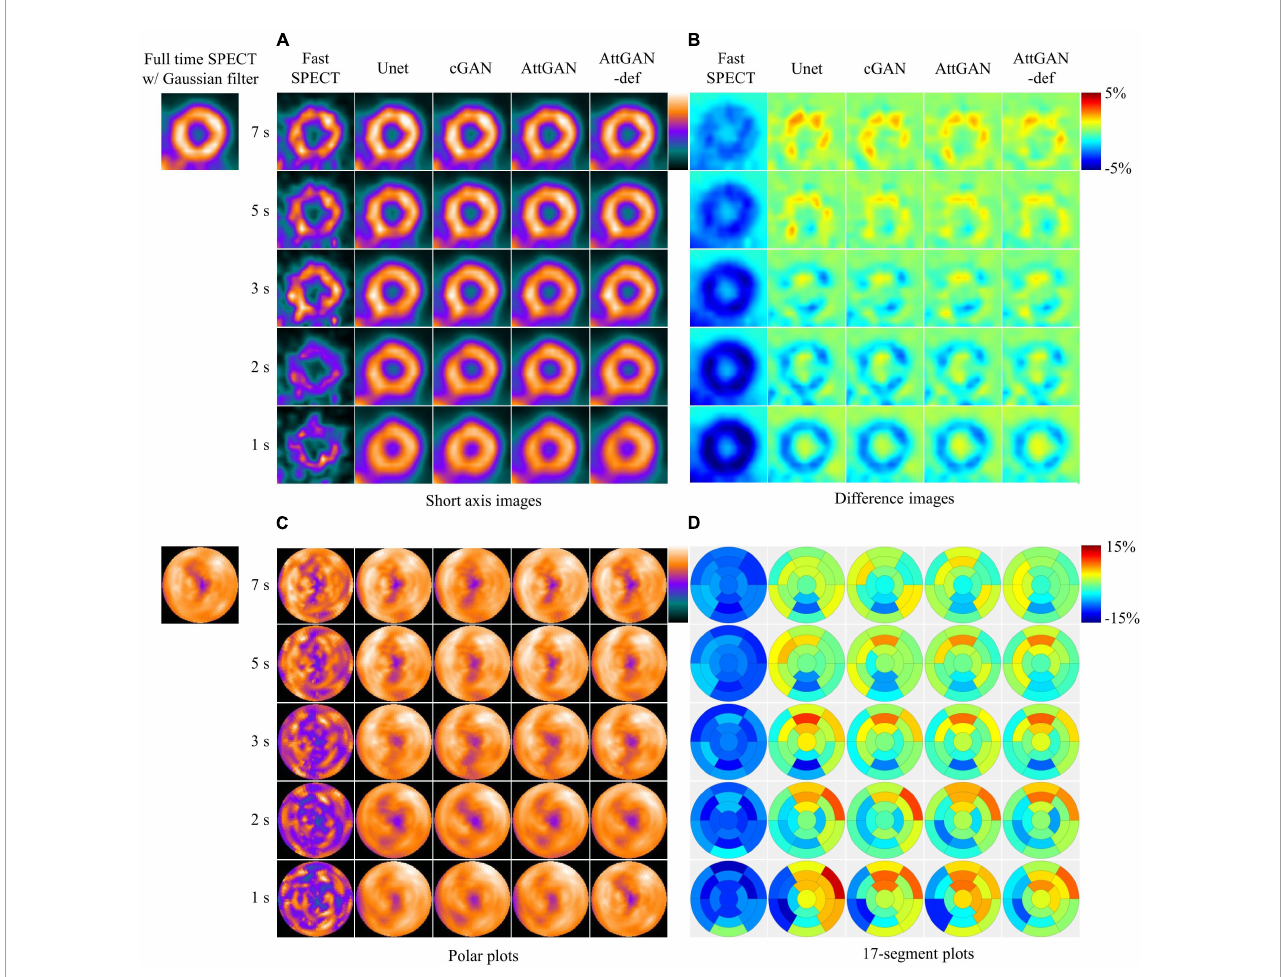
FIGURE4 Sample images of a normal male patient (age = 67, BMI = 25.4) before and after DL-based denoising for five shorter acquisition times. The images are shown in (A) short axis images, (B) difference images as compared to FT SPECT, (C) polar plots, and (D) 17-segment